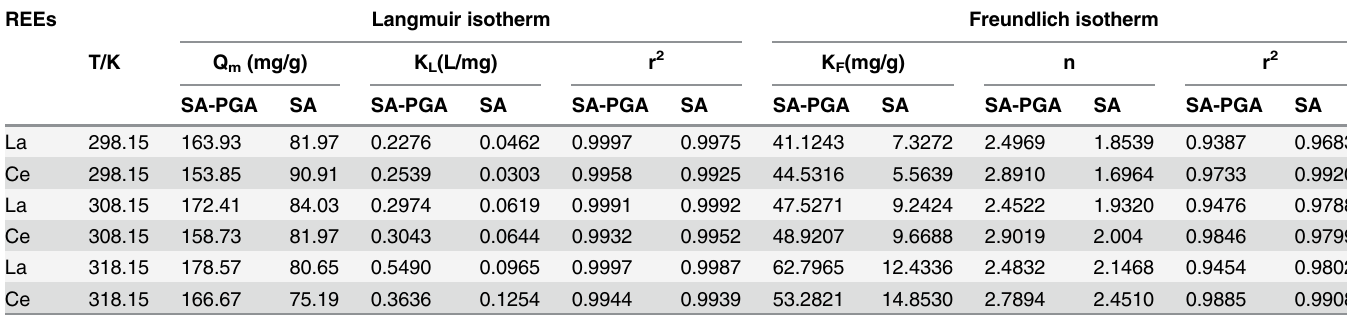
Table 3. Isotherm constants and correlation coefficients for the adsorption of REEs on gel particles at different temperatures. REEs Langmuir isotherm Freundlich isotherm T/K Q m (mg/g) K L